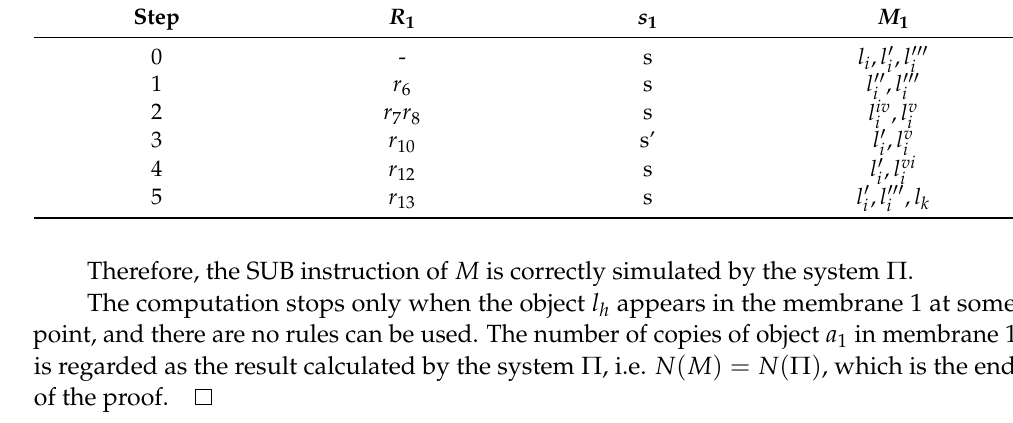
Table 4. The application of rules in R 1 , the evolution of channel states s 1 , and the rewriting of multisets M 1 in membrane 1. During the simulation of a SUB instruction l i :( SUB ( r ) , l j , l k ) with register r empty. R